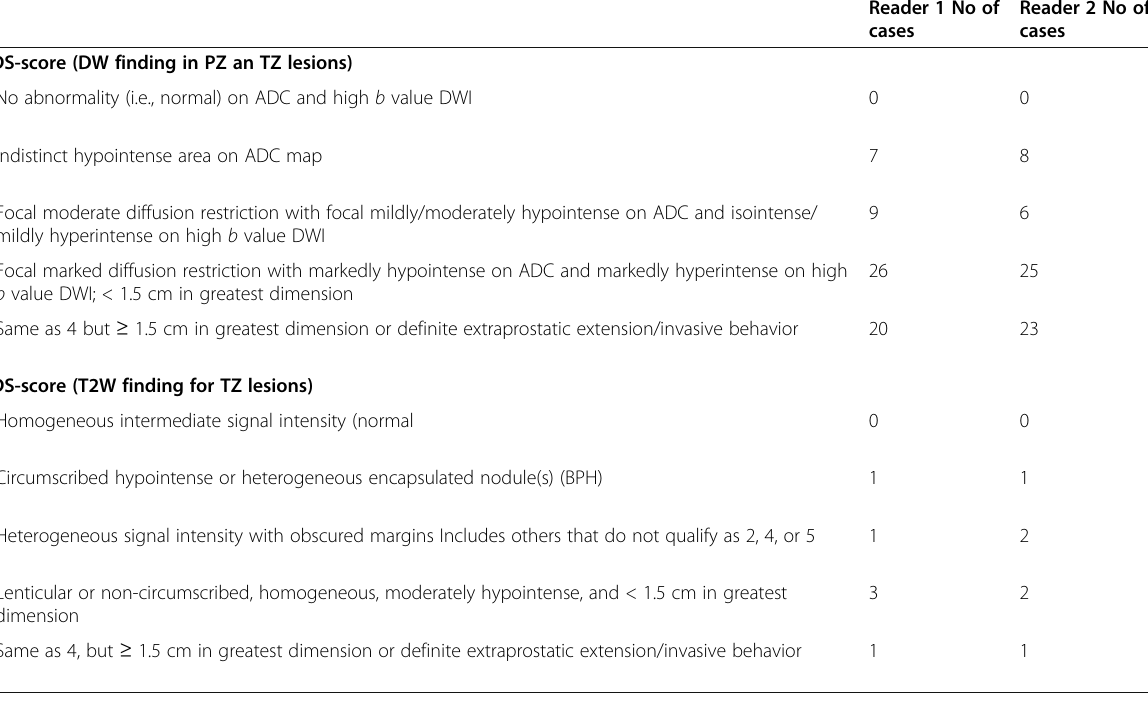
Table 2 PIRADS2 scoring system using DWI for PZ lesions and T2-weighted for TZ